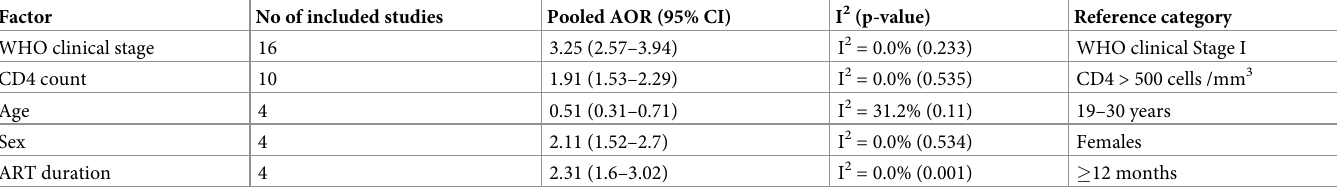
Table 4. Summary of the factors associated with undernutrition among adults living with HIV in sub-Saharan Africa, 2021.